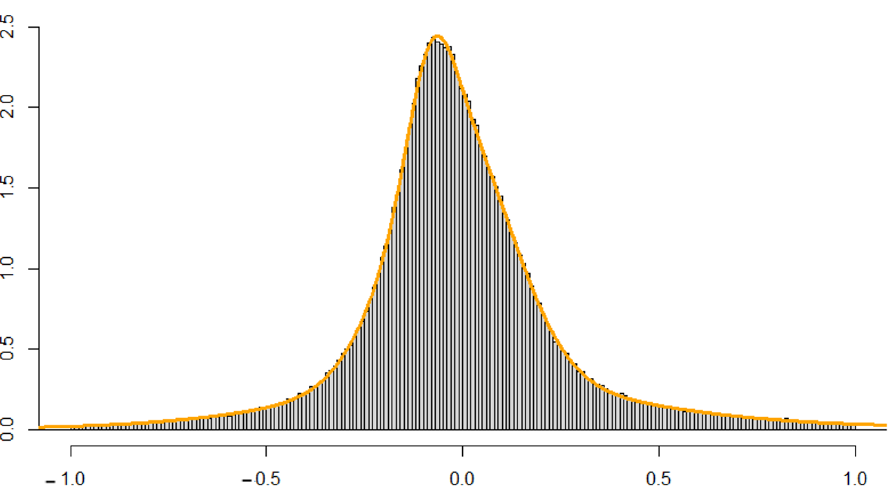
Figure 7. Observed histogram (EDOD) and density function derived from the finite mixture model (FMM) for the discrepancies (colored